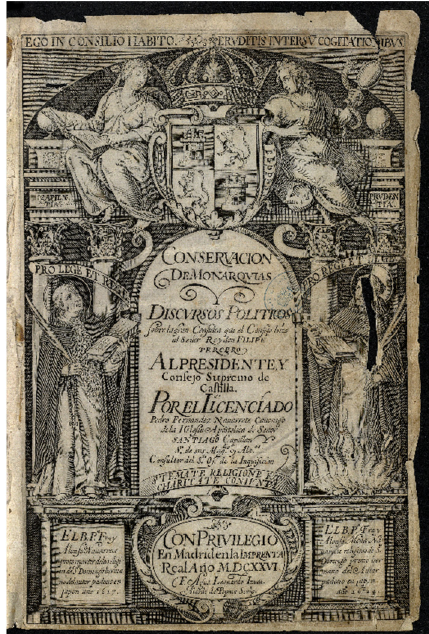
Figure 12. F. Agustín Leonardo y Alardo de Popma. Fray Alonso Navarrete y Fray Fray Alonso Mena Figure 12. F. Agust í n Leonardo y Alardo de Popma. Fray Alonso Navarrete y Fray Fray Alonso Navarrete, mártires, con la Sabiduría y la Prudencia . Book cover of Pedro Fernández Navarrete, Conser- Mena Navarrete, m á rtires, con la Sabidur í a y la Prudencia . Book cover of Pedro Fern á ndez Navarrete, vación de Monarquías y Discursos Políticos… En Madrid en la Imprenta Real Año M.DC.XXVI. (Biblio- Conservaci ó n de Monarqu í as y Discursos Pol í ticos . . . En Madrid en la Imprenta Real Año M.DC.XXVI. teca Nacional de España). (Biblioteca Nacional de